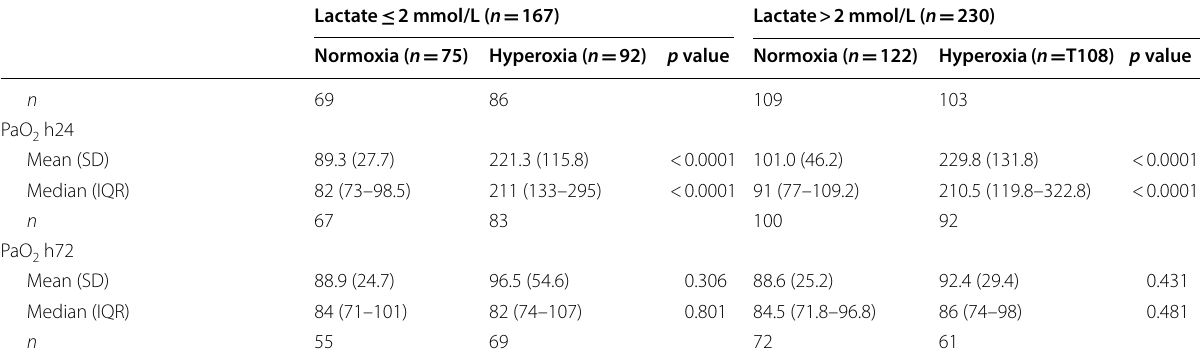
Table 3 Data analysis by using a Cox regression model with survival data censored at 28 days and then censored at 90 days in succession